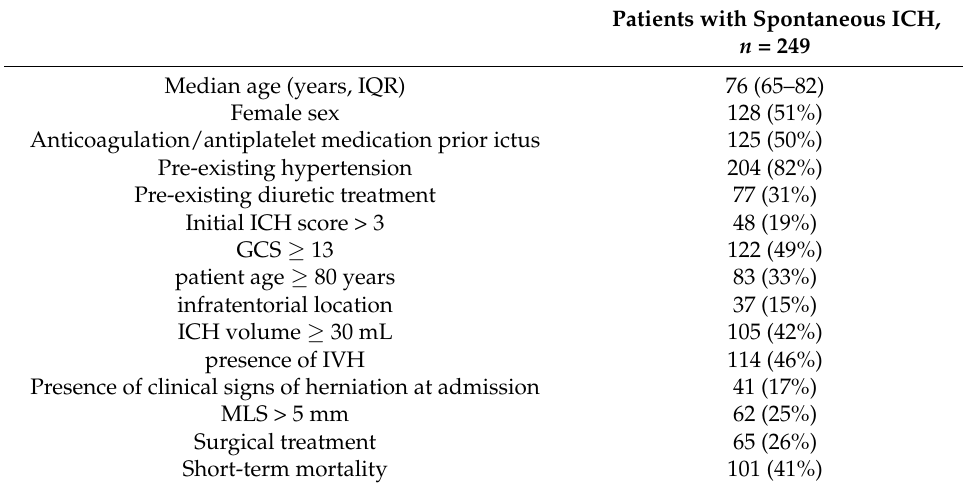
Table 1. Overall patient characteristics. ICH, intracerebral hemorrhage; IQR, interquartile range; GCS, Glasgow Coma Scale; IVH, intraventricular hemorrhage; MLS, midline shift. Patients with Spontaneous ICH,